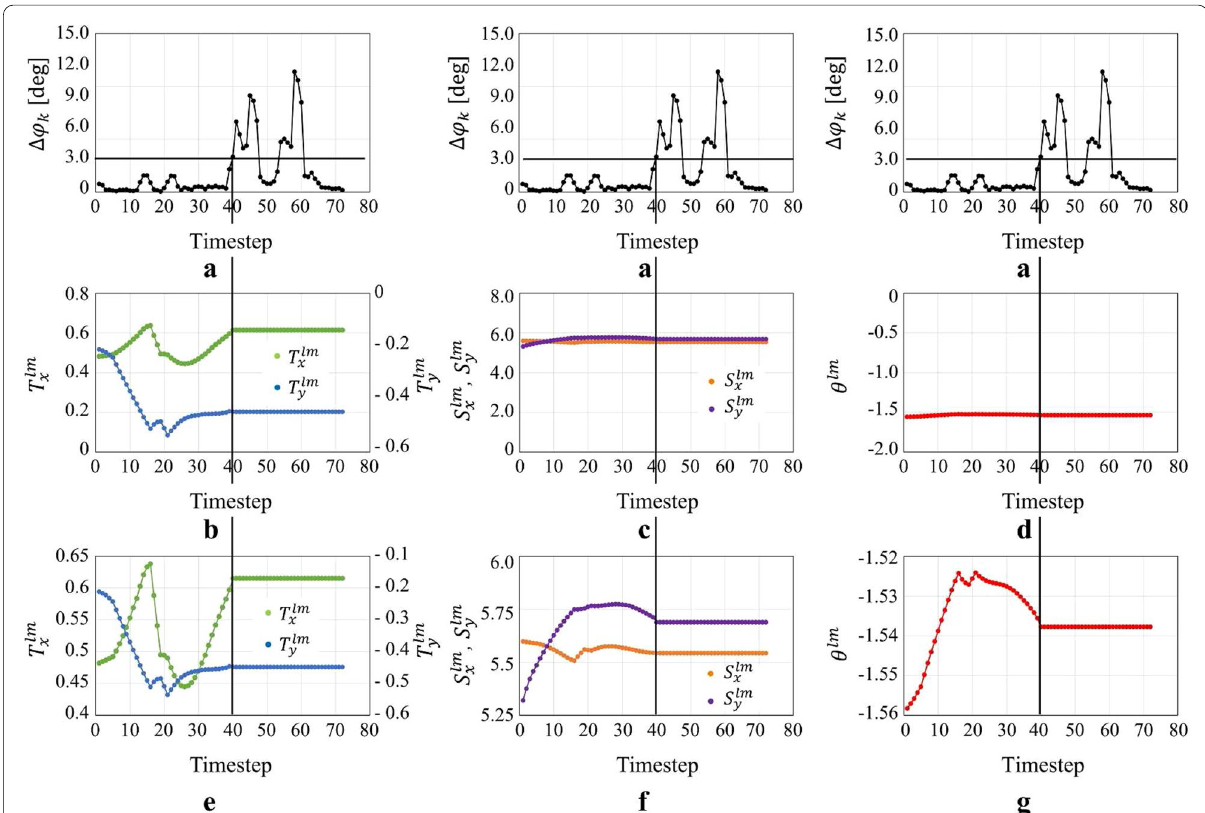
Fig. 11 Transition of the degeneracy detection index and transformation parameters in case of simulation dealing with degeneracy in the direction of rotation. a Degeneracy detection index, b , e Parameter transition of T lm x and T lm y , c , f Parameter transition of S lm x and S lm y , d , g Parameter transition of θ lm